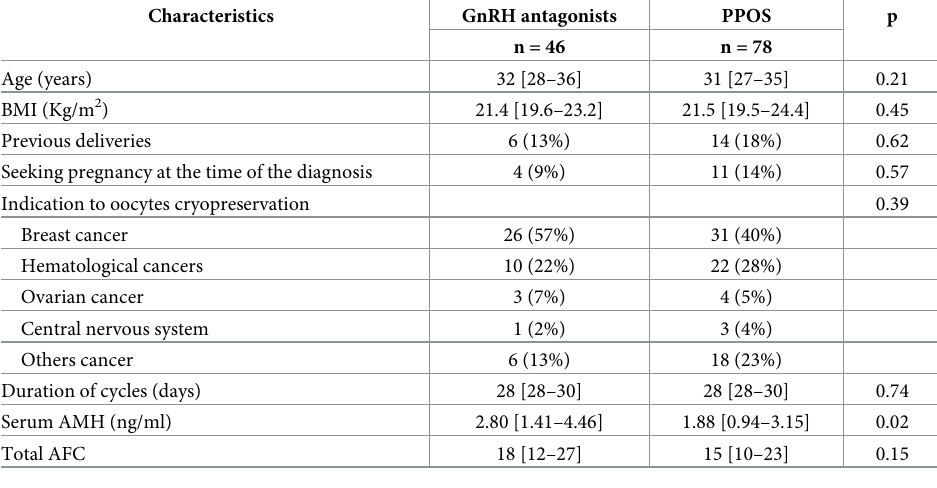
Table 1. Baseline clinical characteristics of the study